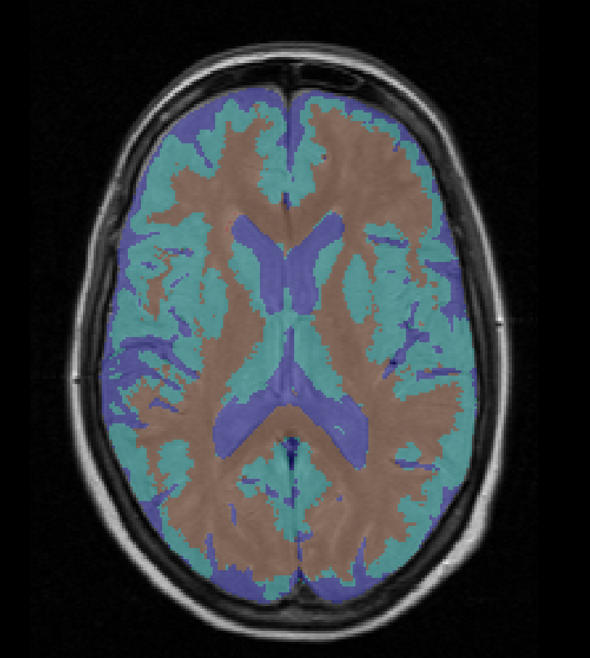
Axial Calculated Magentization Transfer Ratio Image Showing Segmentation of Cebrebrospinal Fluid (Dark Blue), the Gray Matter (Turquoise), and the White Matter (Brown)